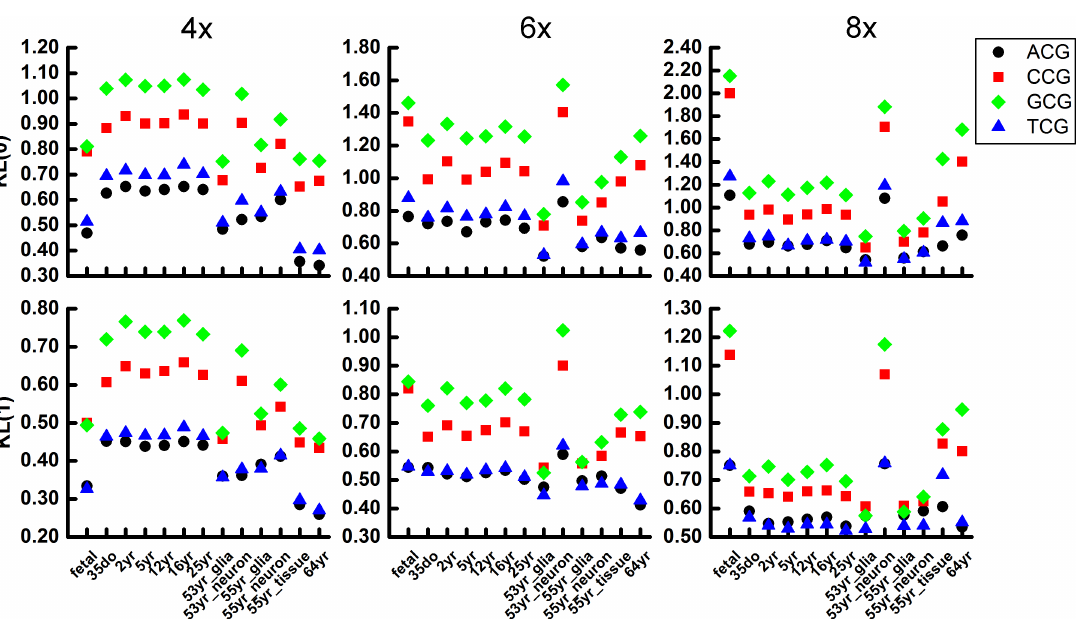
Fig 8. Methylation variation (above) and demethylation variation (below) in human brain cells of difference sequencing depth.